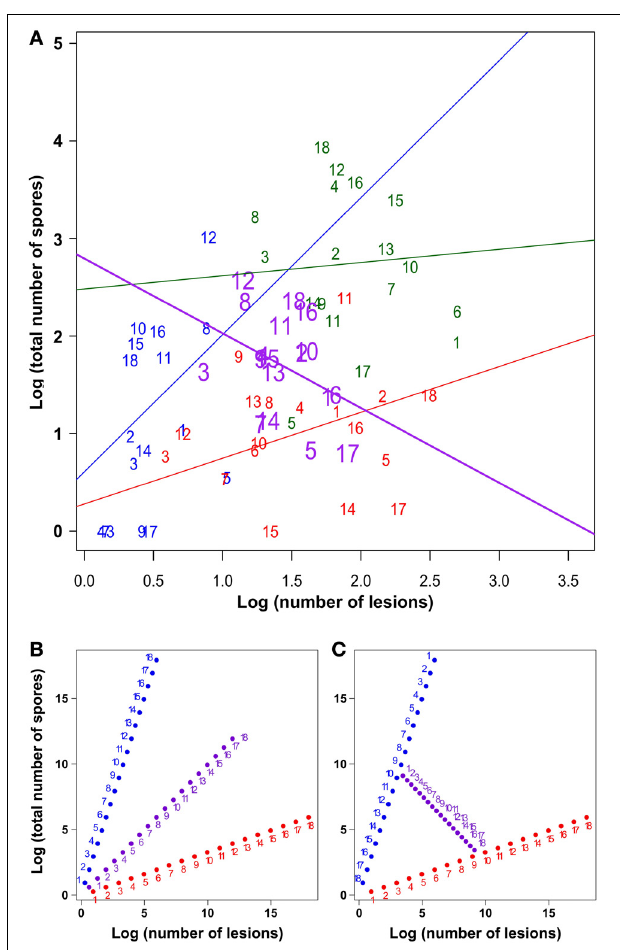
FIGURE 3 | Illustration of the within-variety and inter-fungal strain correlations between infection success (number of lesions) and fungal fitness (total number of spores). The panel (A) shows averaged measures (three replicate measures per strain per variety) of the number of lesions and the total number of spores. Numbers designate fungal strains, blue, red, and green point represent data collected on Ariete, CO39, and Maratelli, respectively. Big purple symbols represent the averaged performance of the 18 fungal strains, on the three varieties, and correspond to the data used to calculate the between-fungal strain correlation. Lines represent linear regressions. Panels (B,C) illustrate the different between-fungal strain correlations (purple points) that are expected (B) when fungal performances on two varieties are positively correlated or (C) when there are G × G interactions i.e., strains performing well on variety 1 perform badly on variety 2. Numbers identify fungal strains, and colors the two varieties (blue = variety 1, red = variety 2). Purple points are the mean values of both the values obtained for variety 1 and 2, data used to calculate inter-fungal strain correlation (purple points are equivalent to big purple symbols on panel A